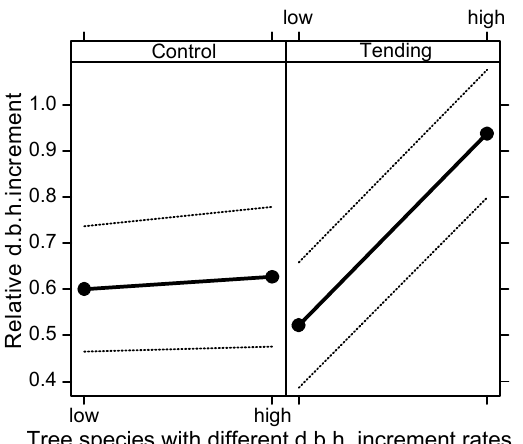
Figure 6. Presentation of the mean relative d.b.h. increment according to treatment and two groups of tree species with different d.b.h. increment rates (see Figure 5); dots and bold lines represent predicted values, holding other variables at fixed values, while dashed lines represent confidence